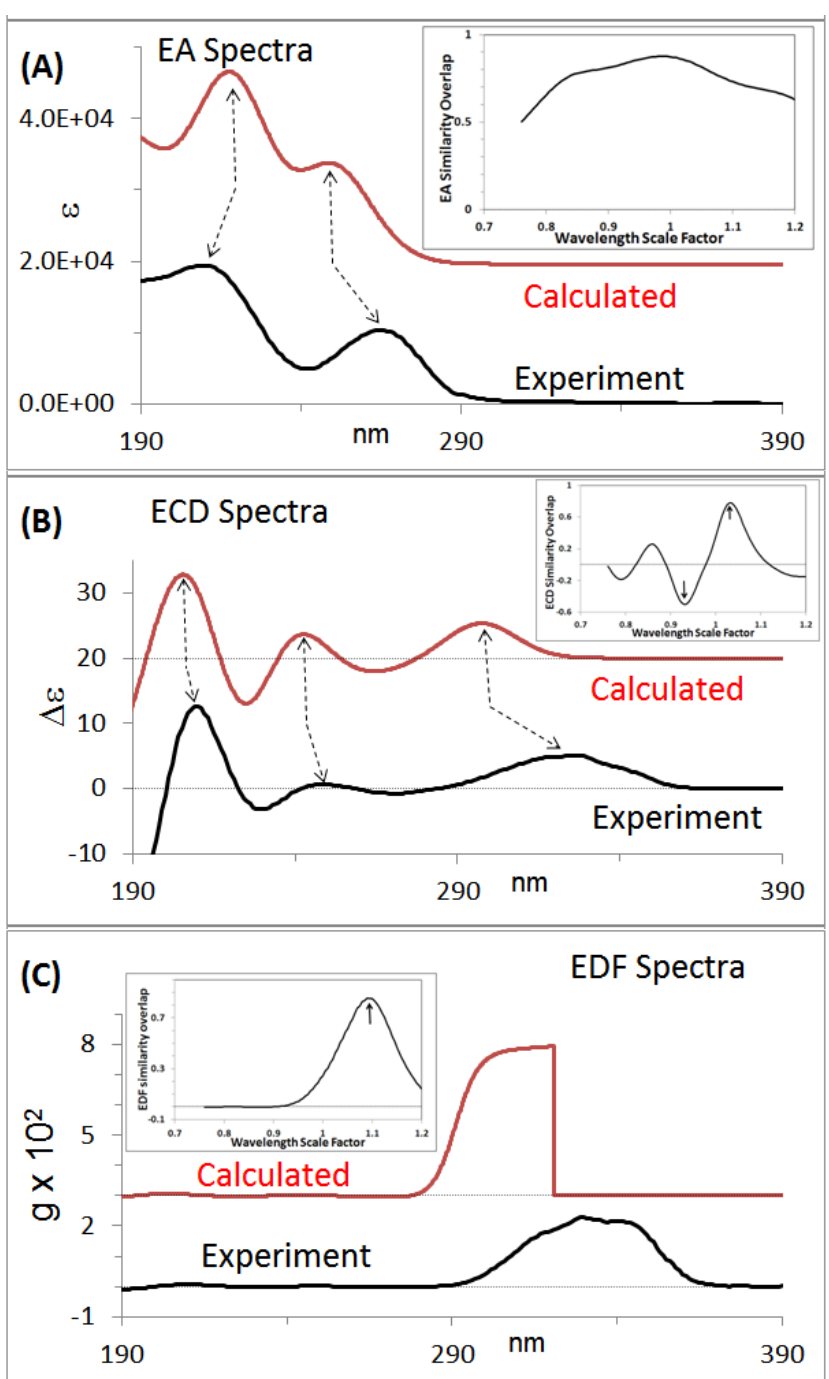
Figure 2. ( A ) Experimental and predicted electronic absorption spectra. Inset shows the similarity overlap plot as a function of wavelength scale factor; ( B ) experimental and predicted ECD spectra. Inset shows the similarity overlap plot as a function of wavelength scale factor; ( C ) experimental and predicted EDF spectra. Inset shows the similarity overlap plot as a function of wavelength scale factor. The experimental spectra are for ( − ) 589 -centratherin and predicted spectra are for (6 R ,7 R ,8 S ,10 R ,2’ Z ) structure. Data taken from Reference [26].